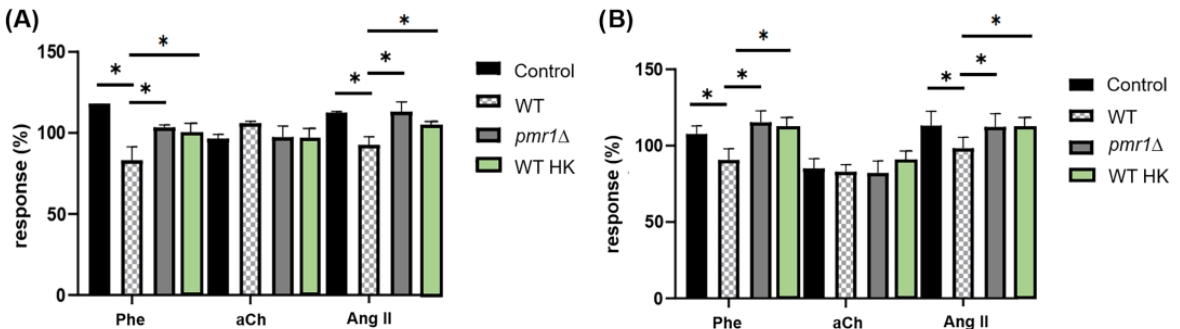
Figure 6. Modification of CPP and LVP in response to agonists when C. albicans HK and C. albicans pmr1 ∆ interact with the coronary endothelium. Heart response, expressed as percentages of ( A ) CPP and ( B ) LVP, when Phe, aCh and Ang II are administered in the absence (Control) and in the presence of C. albicans WT (WT), heat-inactivated C. albicans (WT HK) or C. albicans pmr1 ∆ ( pmr1 ∆ ) yeast. Bars (mean ± SD) show the result of at least three independent experiments (* p < 0.05).